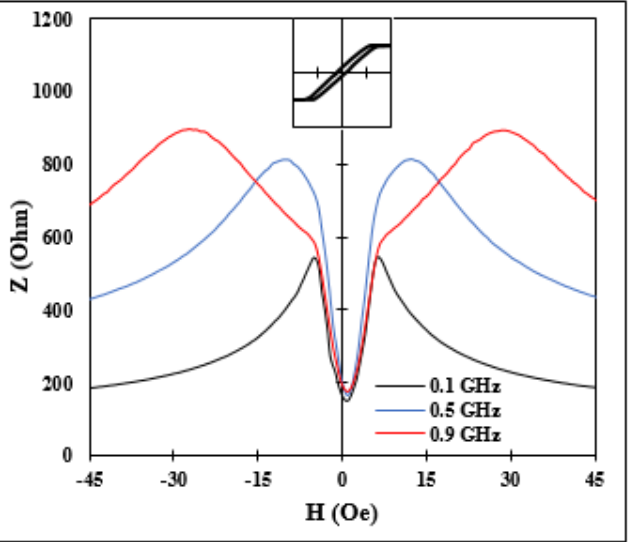
Figure 1. Typical MI in wires with circumferential anisotropy. For this measurement, we used amorphous Co 66.6 Fe 4.28 B 11.51 Si 14.48 Ni 1.44 Mo 1.69 microwires. Inset shows the DC loop along the wire.